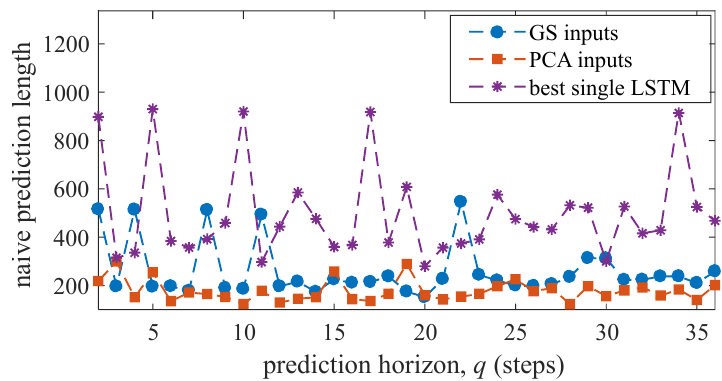
Figure 11. Mean naive prediction length for all tests.